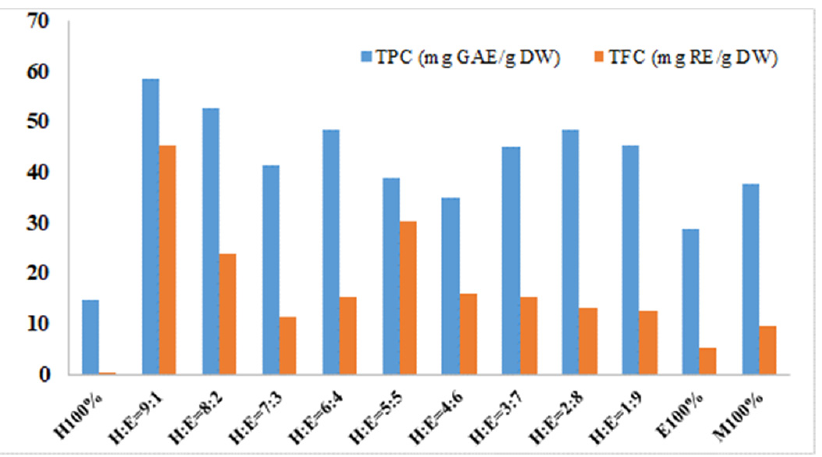
Figure 1. Total phenolic and flavonoids contents in extracts of M. oleifera twigs. Values are means ± SD (standard deviation; p < 0.05; n = 3).